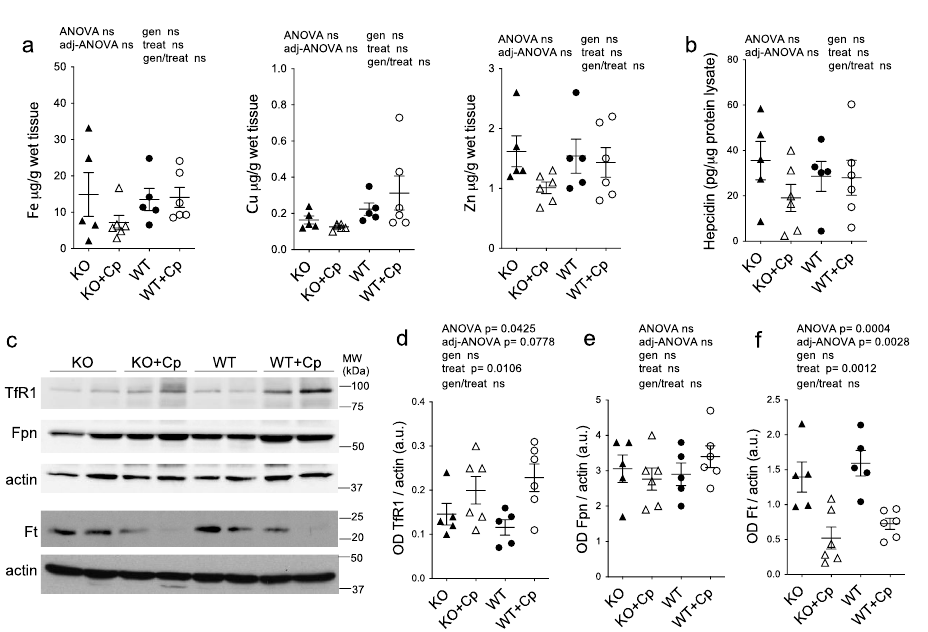
Figure 6. Deposition of metal ions and expression of iron homeostasis-related proteins in perigonadal adipose tissue. ( a ) Iron, copper, and zinc metal ions evaluation by ICP-MS in pgAT from mice at 10 months of age after 2 months of treatment with an intraperitoneal injection of Cp 5 μg/g, administered every 5 days (KO+Cp; WT+Cp) or saline (KO, WT). ( b ) Hepcidin level measured by ELISA in pgAT lysates of mice treated as in ( a ). ( c ) Western blot analysis of transferrin receptor 1 (TfR1), ferroportin 1 (Fpn), ferritin (Ft) and actin expression in pgAT of mice treated as in ( a ). Cropped images are from the same or twin SDS-PAGE and Western blot but at a different exposure. ( d – f ) Densitometric analysis of Western blot signals for TfR1( d ), Fpn ( e ) and Ft ( f ) was performed with ImageJ software; values are reported as optical density (OD) normalized for actin. Data: mean ± SEM of animal groups; each dot corresponds to one animal (CpKO, WT n = 5; CpKO+Cp, WT+Cp, n = 6); statistical p -values were evaluated by two-ways ANOVA and reported as value for overall ANOVA, value for Benjamini-Hochberg adjustment for multiple ANOVA tests related to adipose tissue features (adj-ANOVA), for genotype variable (gen), for treatment variable (treat) and for the interaction of genotype/treatment